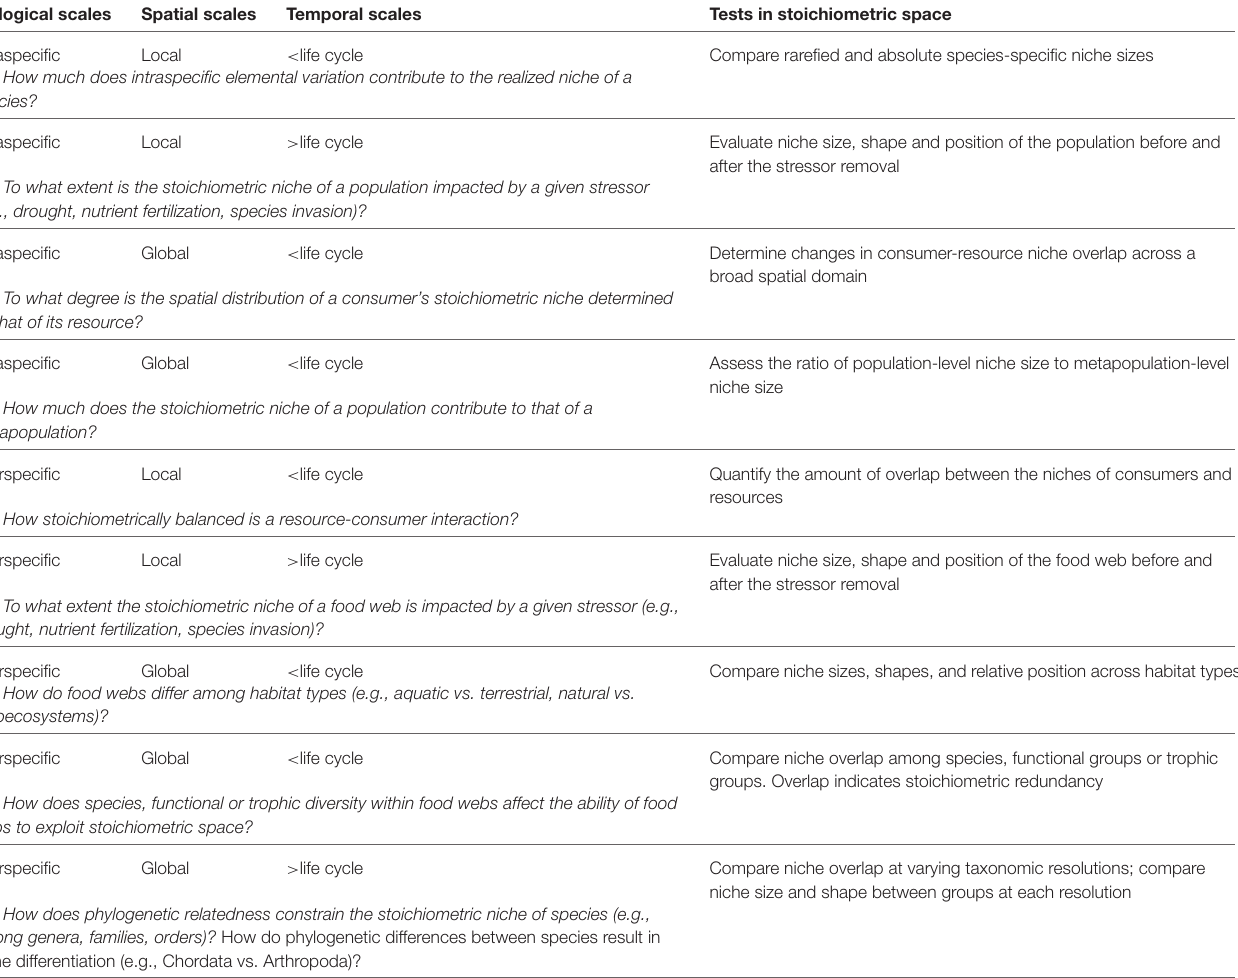
TABLE 1 | Examples of questions that could be addressed using the multidimensional stoichiometric niche approach, including the biological, spatial and temporal scales involved, and the associated tests to be conducted. Biological